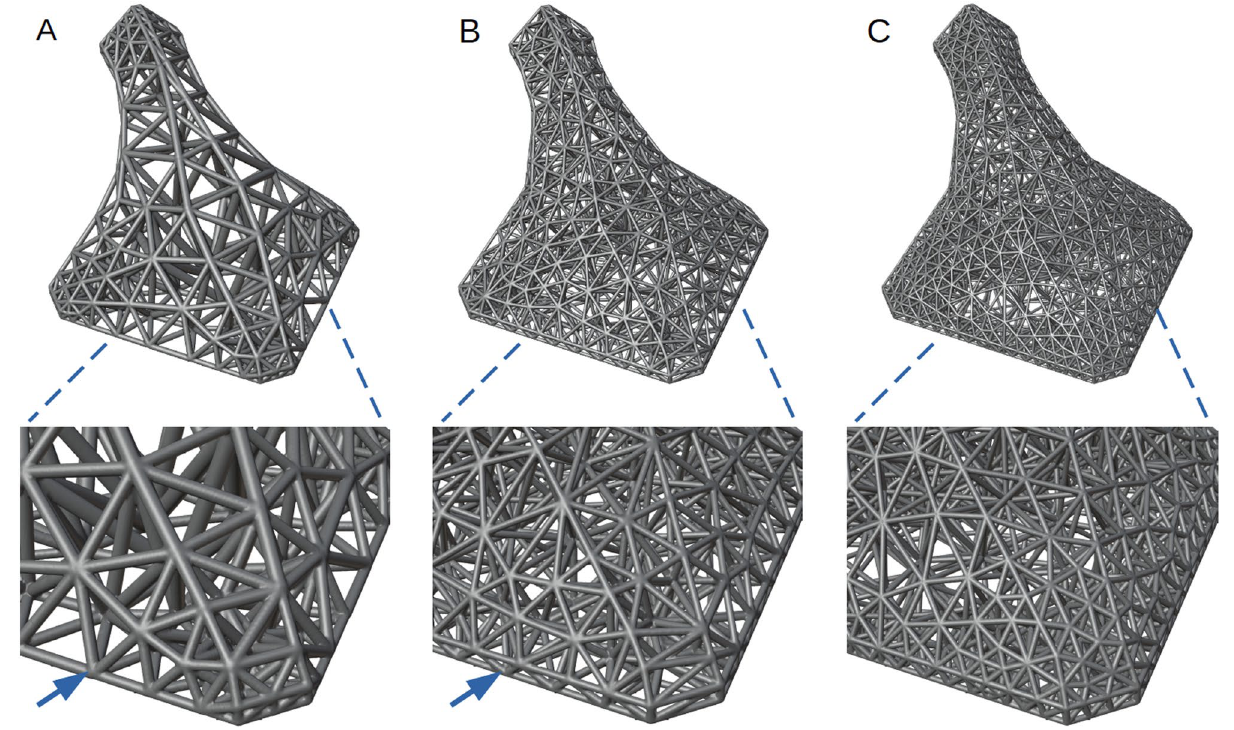
Figure 11. Low, mid, and high density HGon meta-structures. The low-density ( A ) struts are thicker, and the long edge feature consolidated to one lower edge at the bottom boundary (arrows). The mid density ( B ) and high density ( C ) HGons have decreased strut length-diameter and hence capture finer